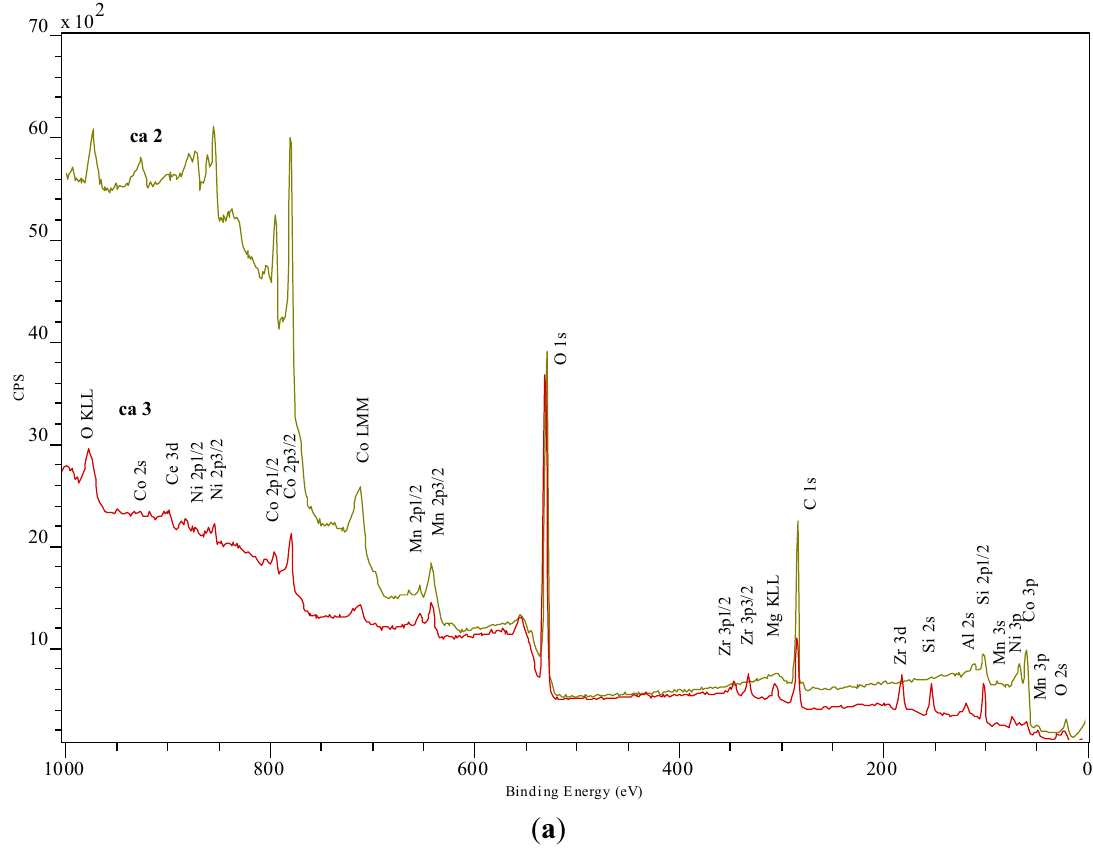
–NiO–Co O /Ce Zr O /cordierite): ( a ) survey spectra; ( b ) Mn region; 2 3 4 0.2 0.8 2